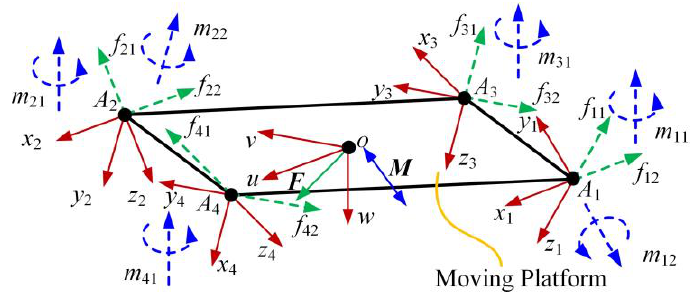
Figure 5. Reaction forces and external loads acting on the moving platform.